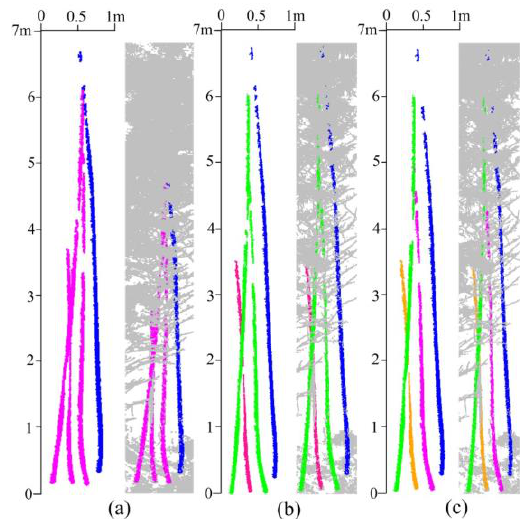
Figure 8. Error correction: ( a ) Error connected results; ( b ) results by setting ; and ( c ) merged results by setting